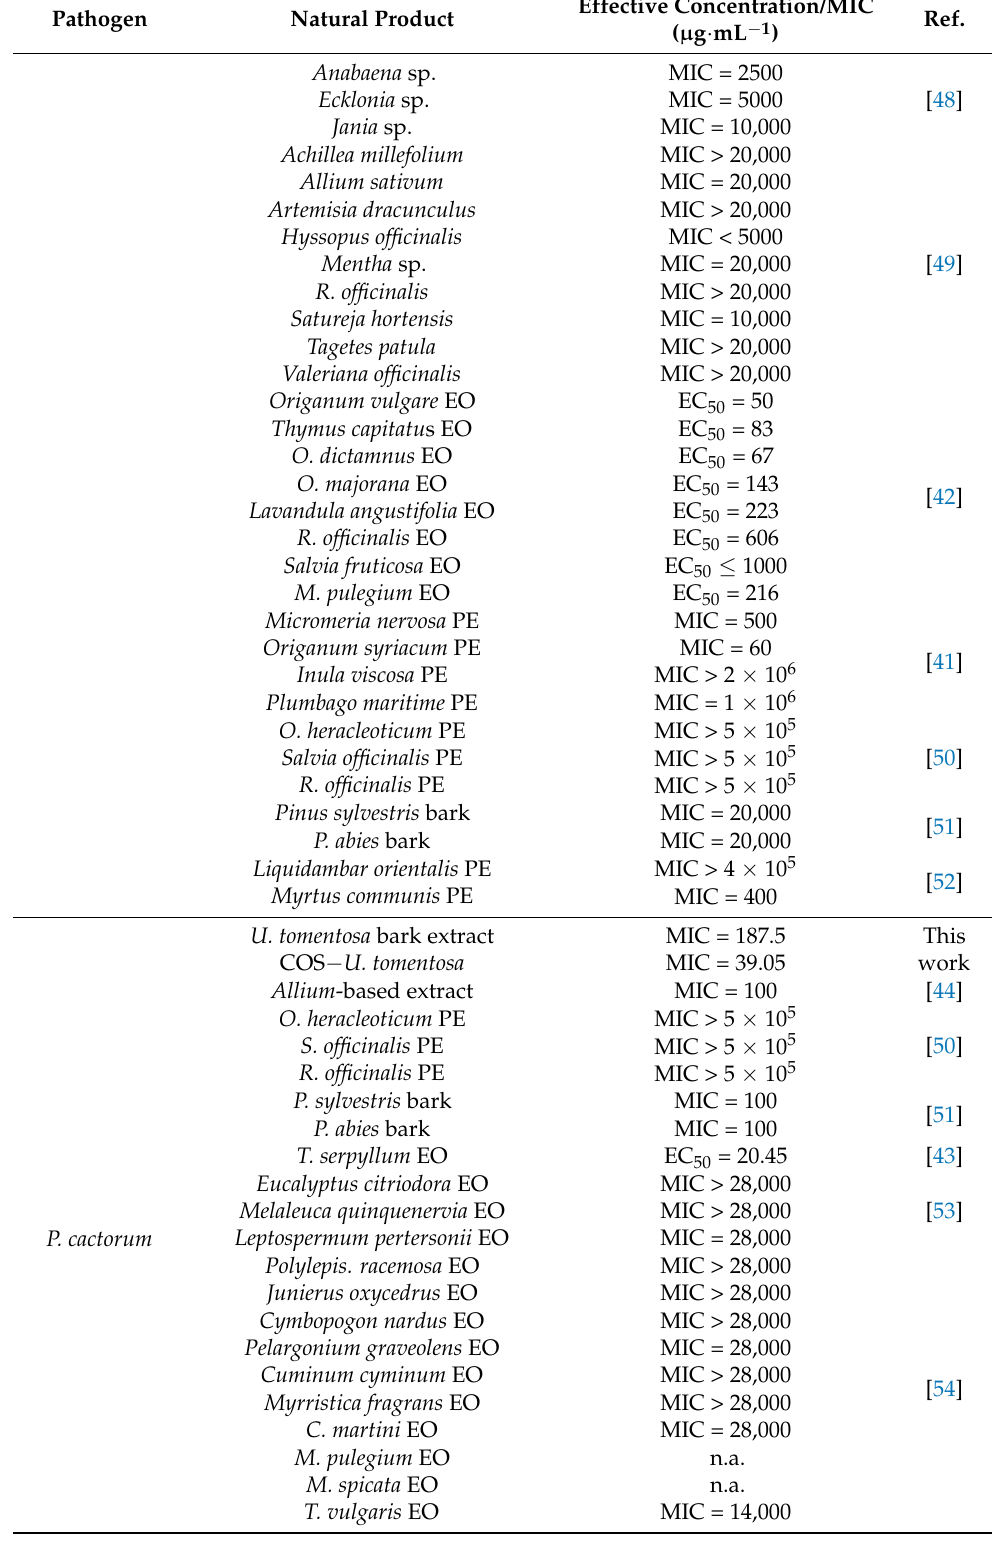
Table 6. Cont. Pathogen Natural